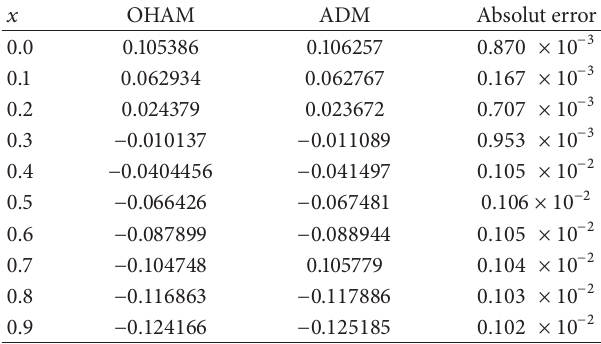
Table 1: Comparison of (OHAM) and (ADM) for lift velocity profile.